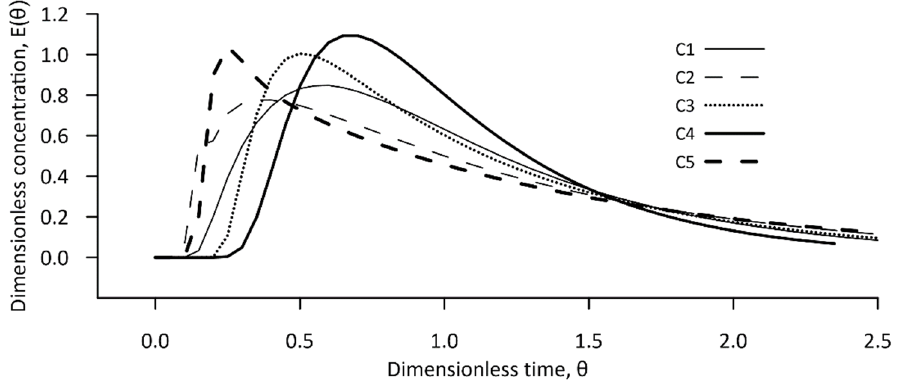
Figure 7. Comparison of RTD curves for IDS configurations